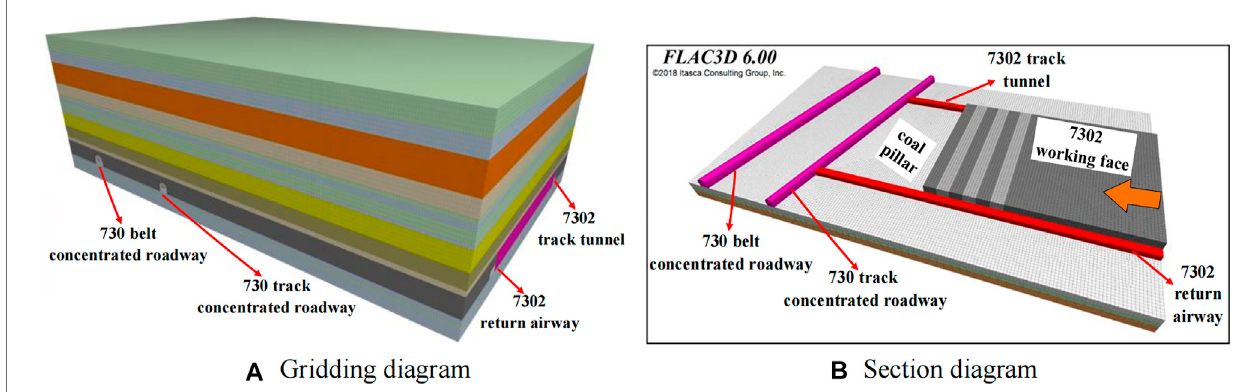
FIGURE 11 | Numerical model diagram. (A) Gridding diagram; (B) Section